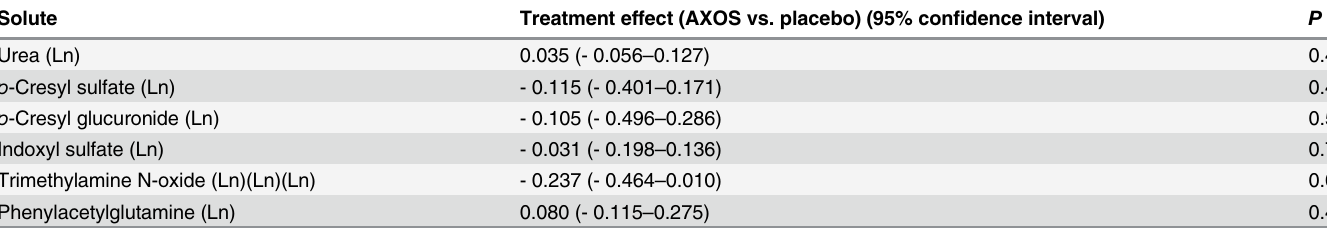
Table 2. Influence of arabinoxylan oligosaccharides (AXOS) on serum levels of microbial metabolites.